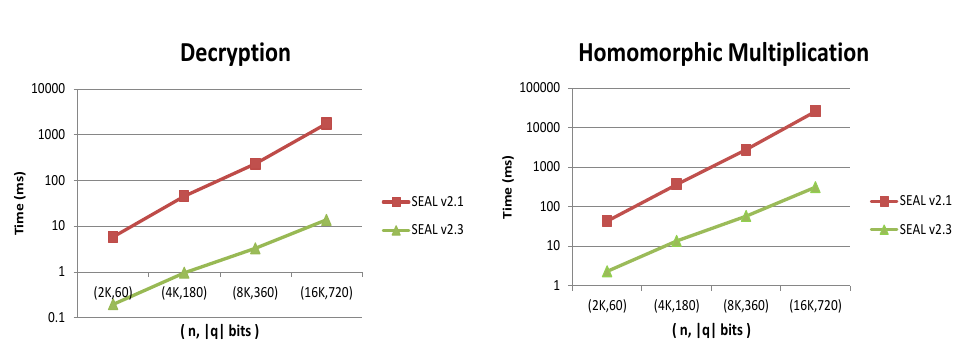
Figure 2: Performance of decryption and homomorphic multiplication in the textbook FV (implemented in SEAL (v2.1)) and its RNS variant (implemented by SEAL (v2.3.0-4)) averaged over 500 runs. Both versions were run on Intel(R) Xeon(R) E5-2620 at 2.40 GHz with 24 cores equipped with ArchLinux (4.8.13-1-ARCH). Note that the vertical axes in the figures are in log